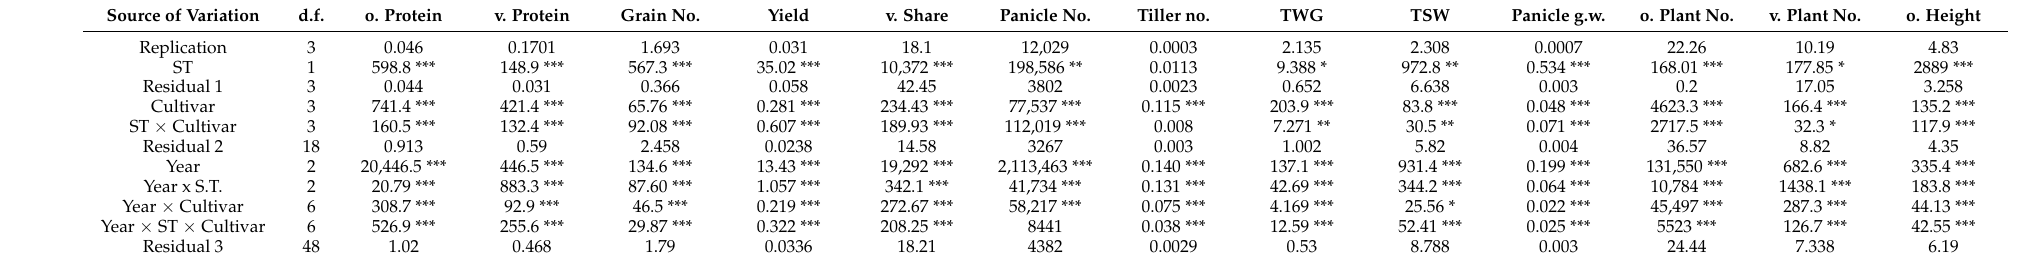
Table 3. Mean squares from three-way analysis of variance for observed